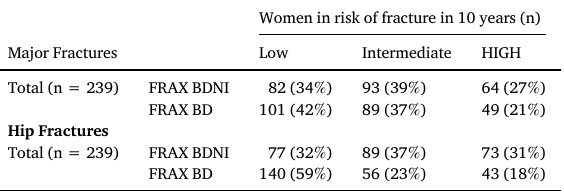
Table 3 Patients classi fi cation by risk of fracture in 10 years.